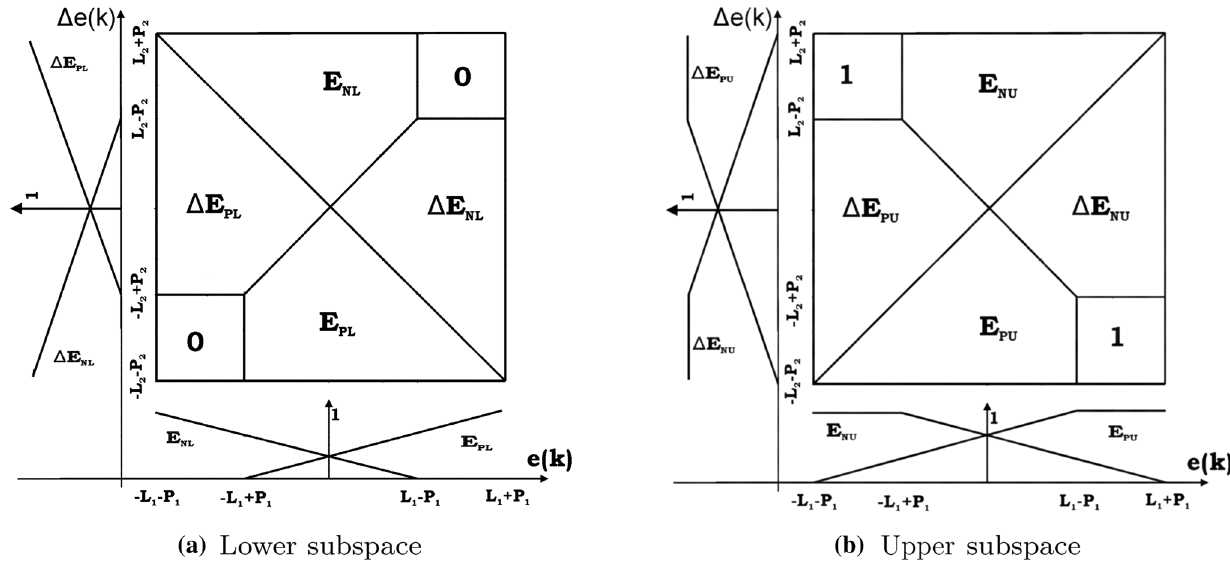
Fig. 5 Lower and upper subspaces with respect to Rule 2